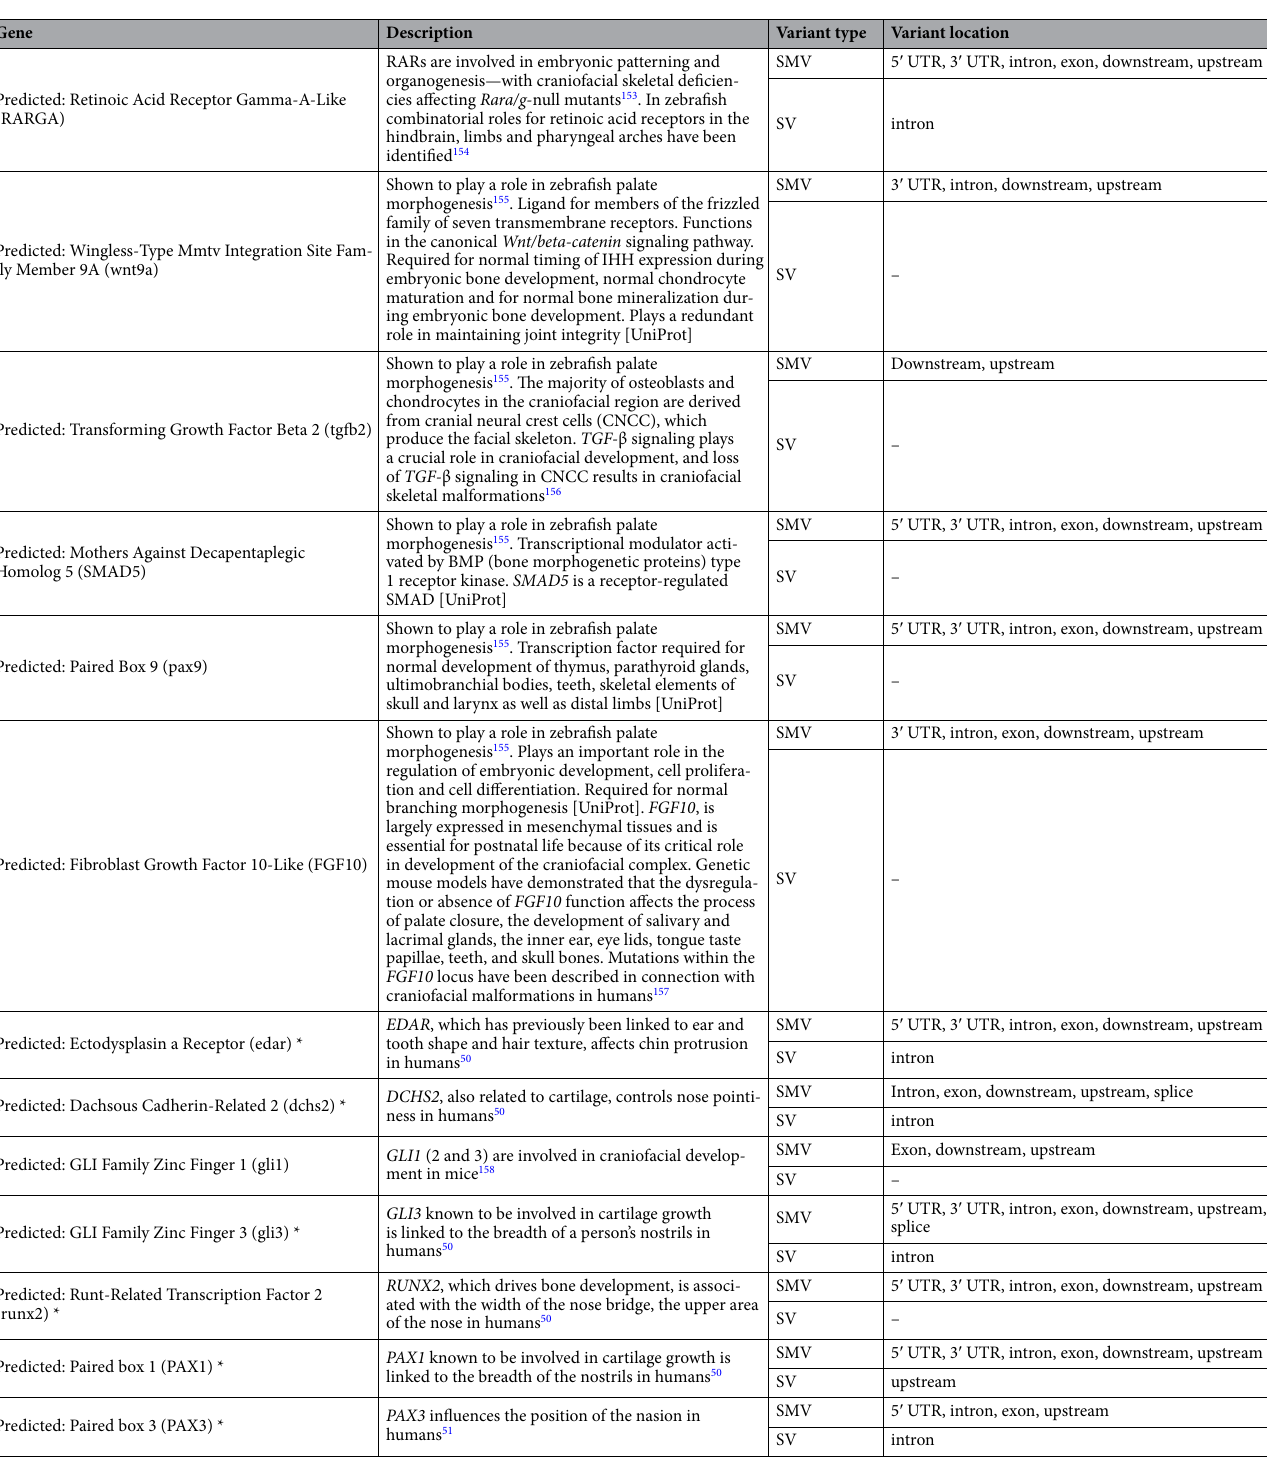
Table 10. Selected genes affected by variants. To narrow down the list of genes carrying variants, a targeted approach and GO enrichment analysis were performed; this table lists genes related to facial and jaw morphology . Shown results are filtered and simplified: (1) variant types and locations have been unified for transcript isoforms and (annotated) gene duplicates, and (2) they have been intersected between species comparisons. SMV, small variant(s); SV, structural variant(s). *Also identified in human to play a role in craniofacial morphology. **Other family member identified in human to play a role in craniofacial